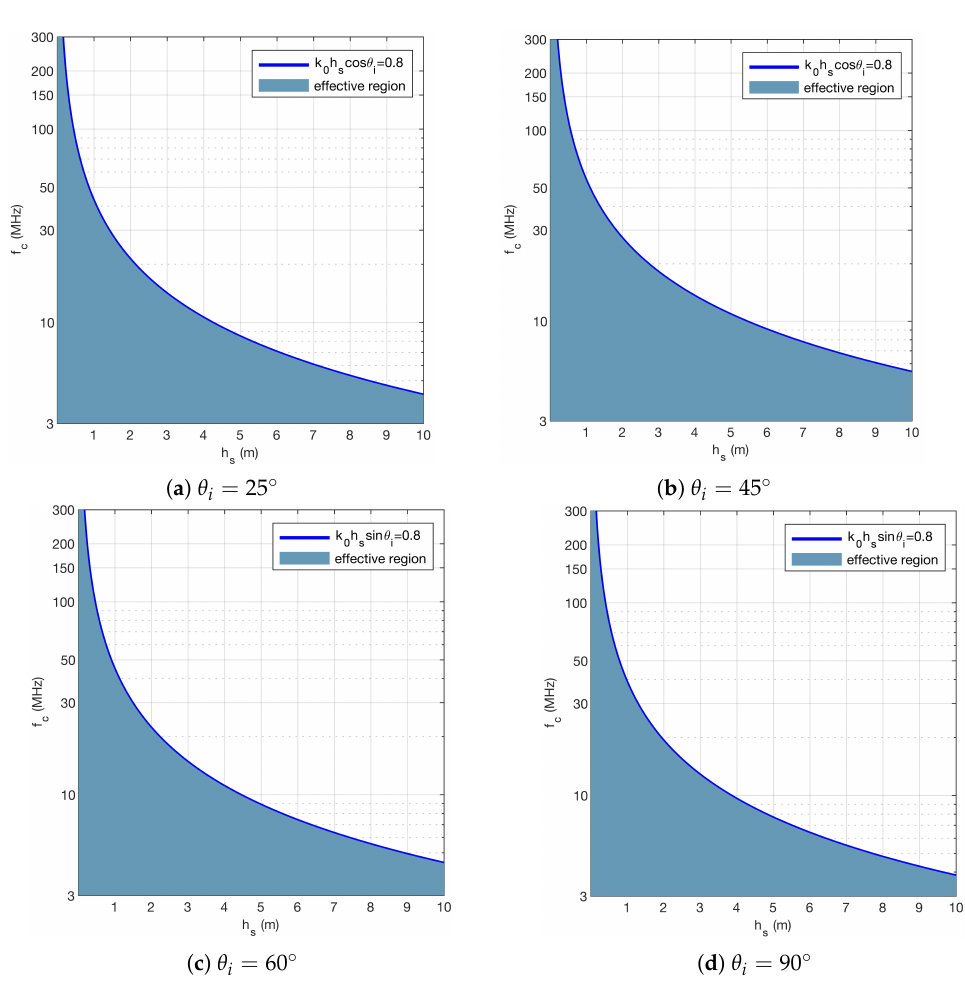
Figure 2. The effective region of the NRCS σ ( ω d , θ i ) . In ( a ) θ i = 25 ◦ , ( b ) θ i = 45 ◦ , ( c ) θ i = 60 ◦ and ( d ) θ i = 90 ◦ , the area filled with dark blue is the effective region for each